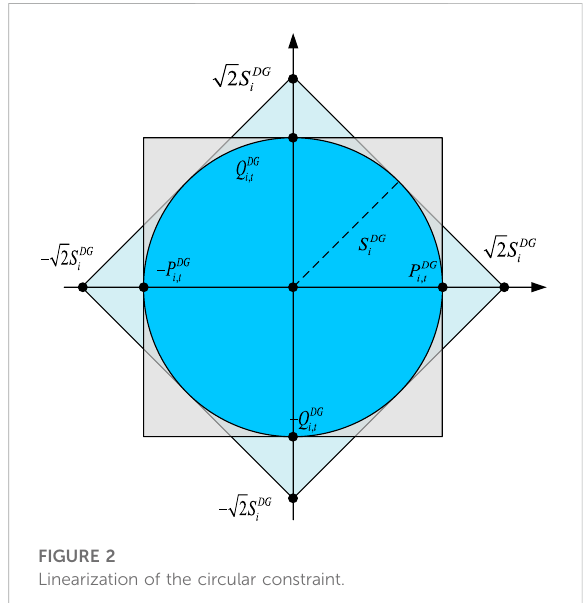
FIGURE 2 Linearization of the circular